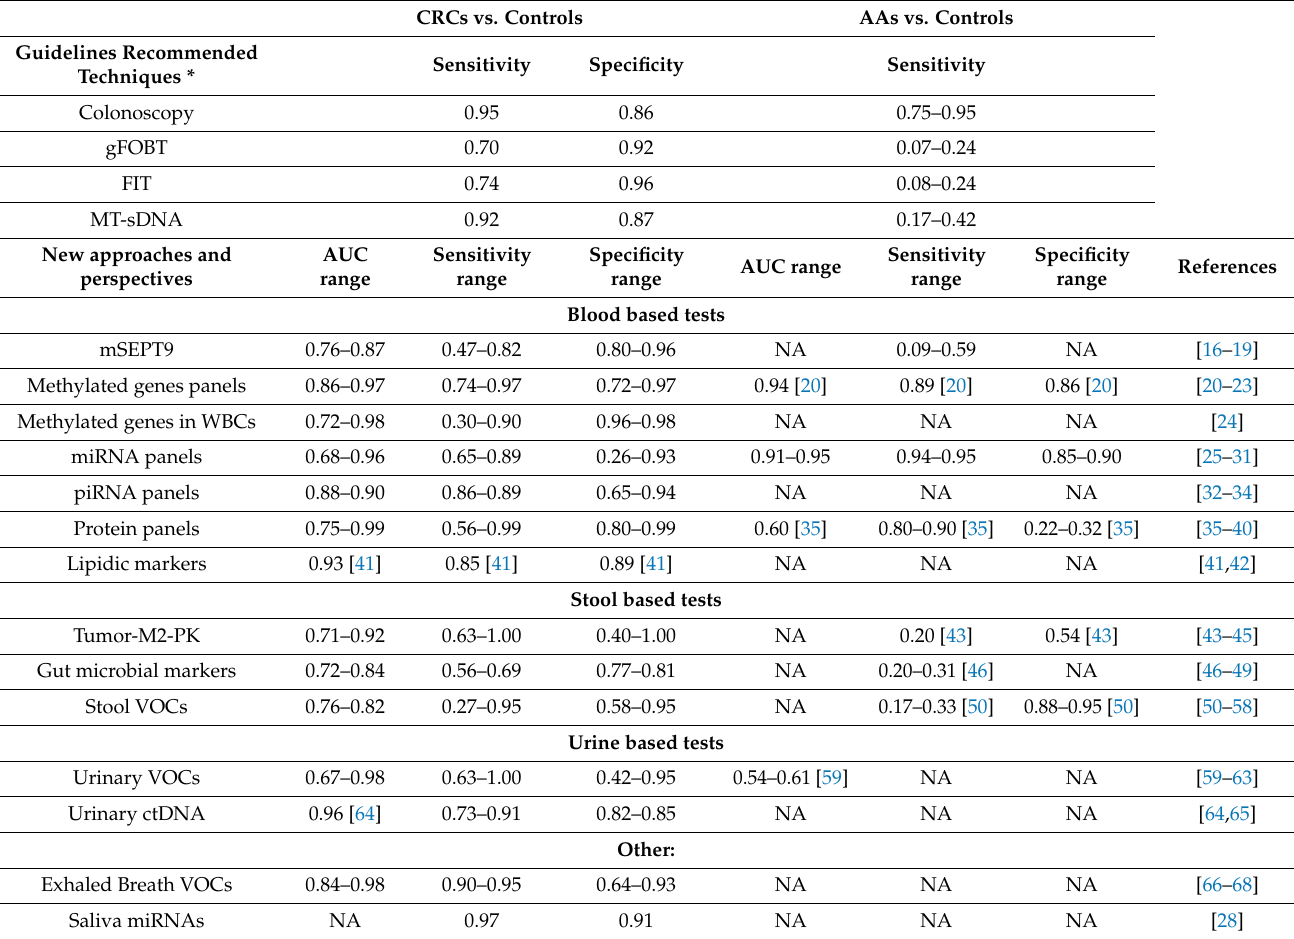
Table 1. Review summary.